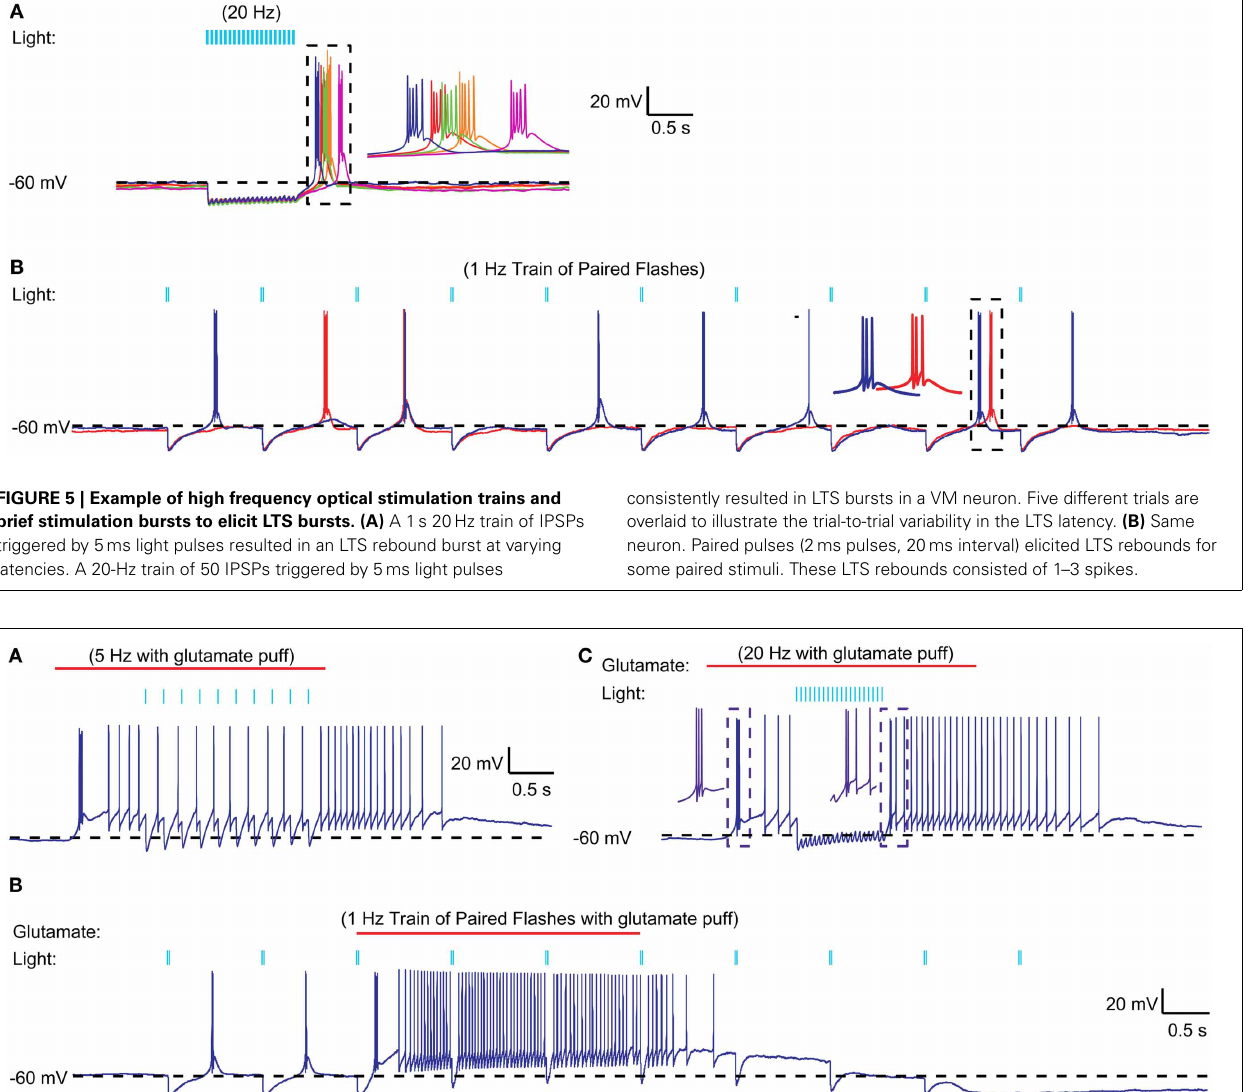
FIGURE 6 | Interaction of optically stimulated nigral IPSPs with glutamatergic excitation. (A) Glutamate (0.5mM) was “puffed” at the recorded neuron for 3s (red line) with a patch pipette brought in close proximity. During the single spike mode triggered by glutamate excitation a 5Hz train of 10ms light pulses (indicated by blue bars) causes pauses in spiking but not LTS rebound burst is evoked. (B)